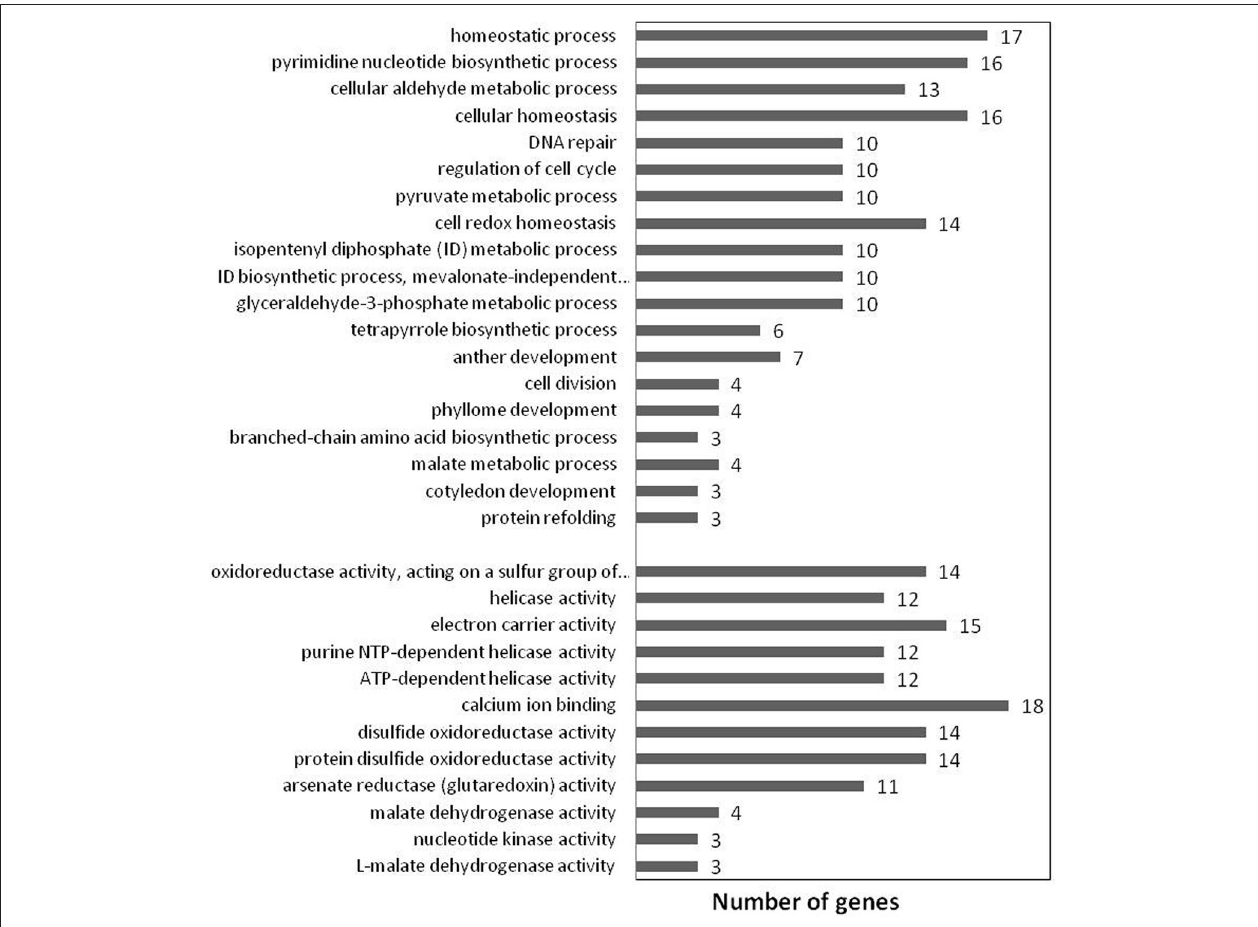
FIGURE 4 | Significantly overrepresented GO terms for Podophyllum Germination Network, reflecting processes and functions known to be relevant for seed germination.